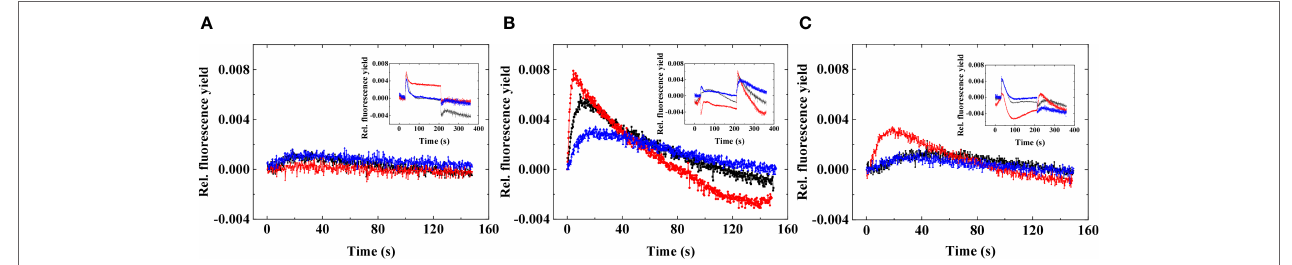
FIGURE 2 | Representative post-illumination Chl fluorescence rise in three different strains of Symbiodiniaceae under elevated temperatures. (A) Fugacium kawagutii (CS156), (B) Symbiodinium tridacnidorum (2465), and (C) Symbiodinium microadriaticum (2467), including control (black), 34°C 2 h (red), and recovery (blue). The fluorescence was adjusted to 0 at the beginning of the post-illumination (dark) phase to display relative changes. Insets show the original traces; here, the minimum fluorescence before the actinic illumination is adjusted to 0 to display relative differences in fluorescence